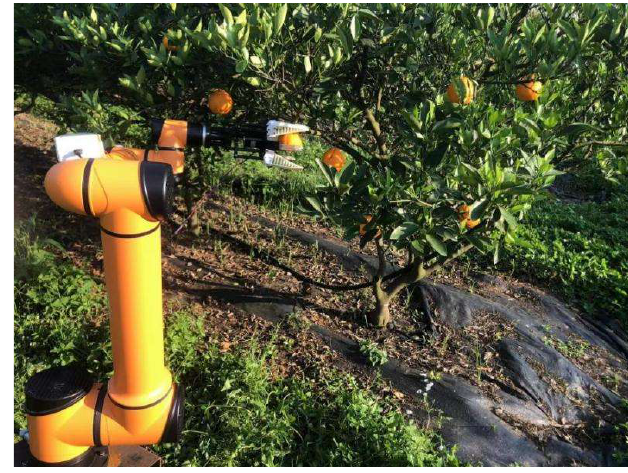
Figure 12. Picking test diagram of the end-effector.